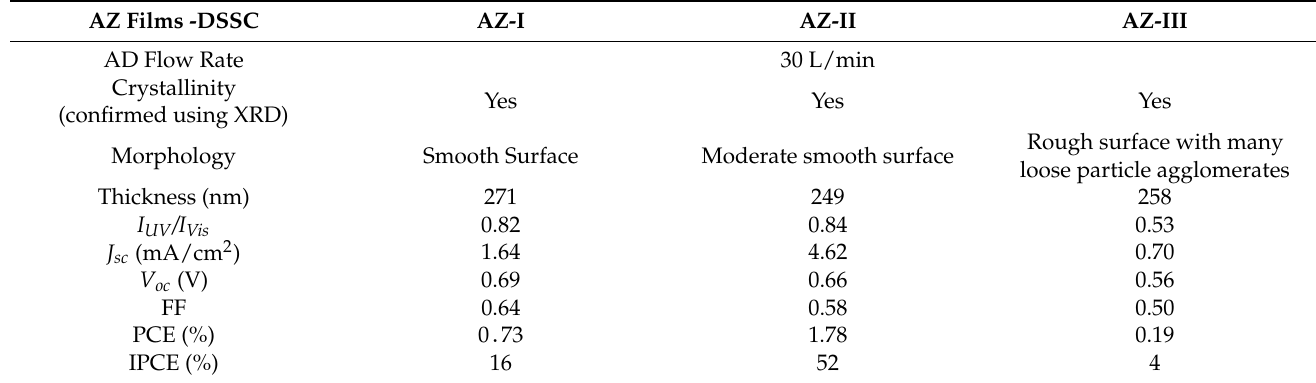
Table 3. A summary of the properties obtained using the